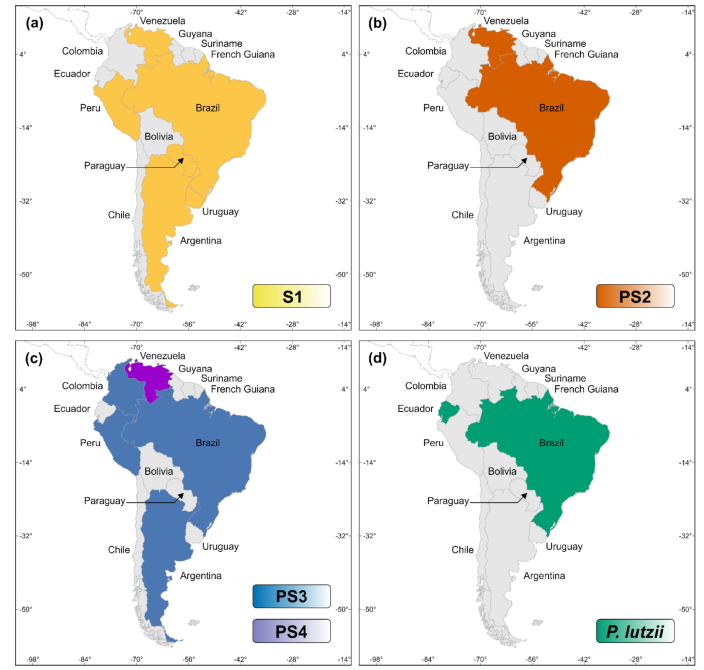
Figure 2. Distribution patterns of Paracoccidioides species in South America, based on epidemiological reports in the literature [19,23,24,27,28]. ( a ) P. brasiliensis sensu stricto (S1); ( b ) P. americana (PS2); ( c ) P. restrepiensis (PS3), and P. venezuelensis (PS4); ( d ) P. lutzii